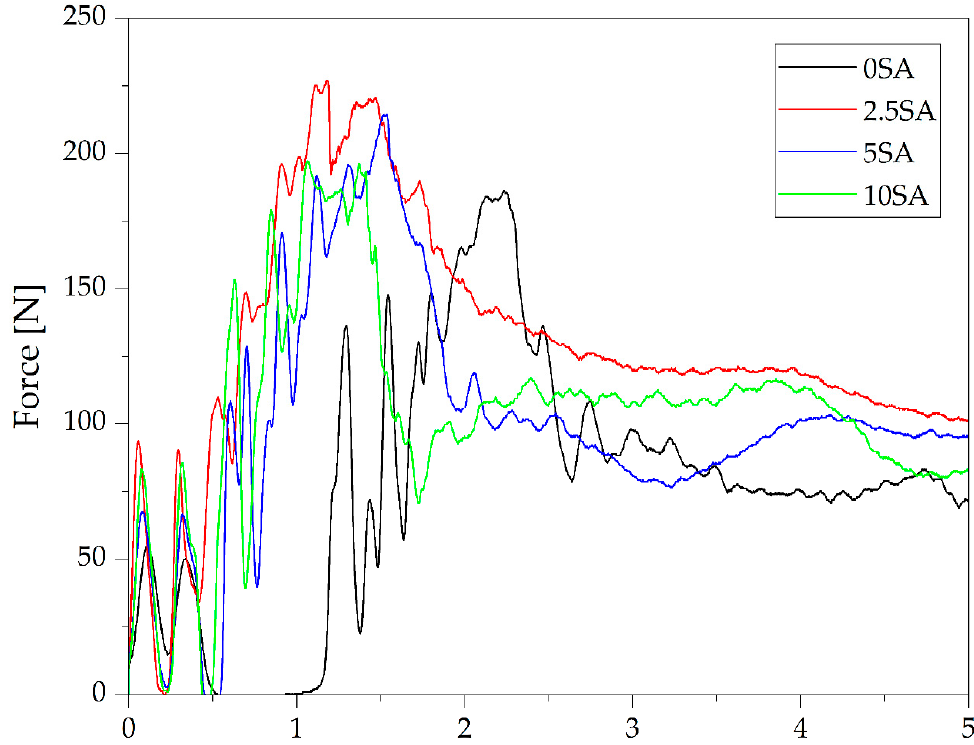
Figure 8. The load–displacement curves of the investigated composites with sunflower husk